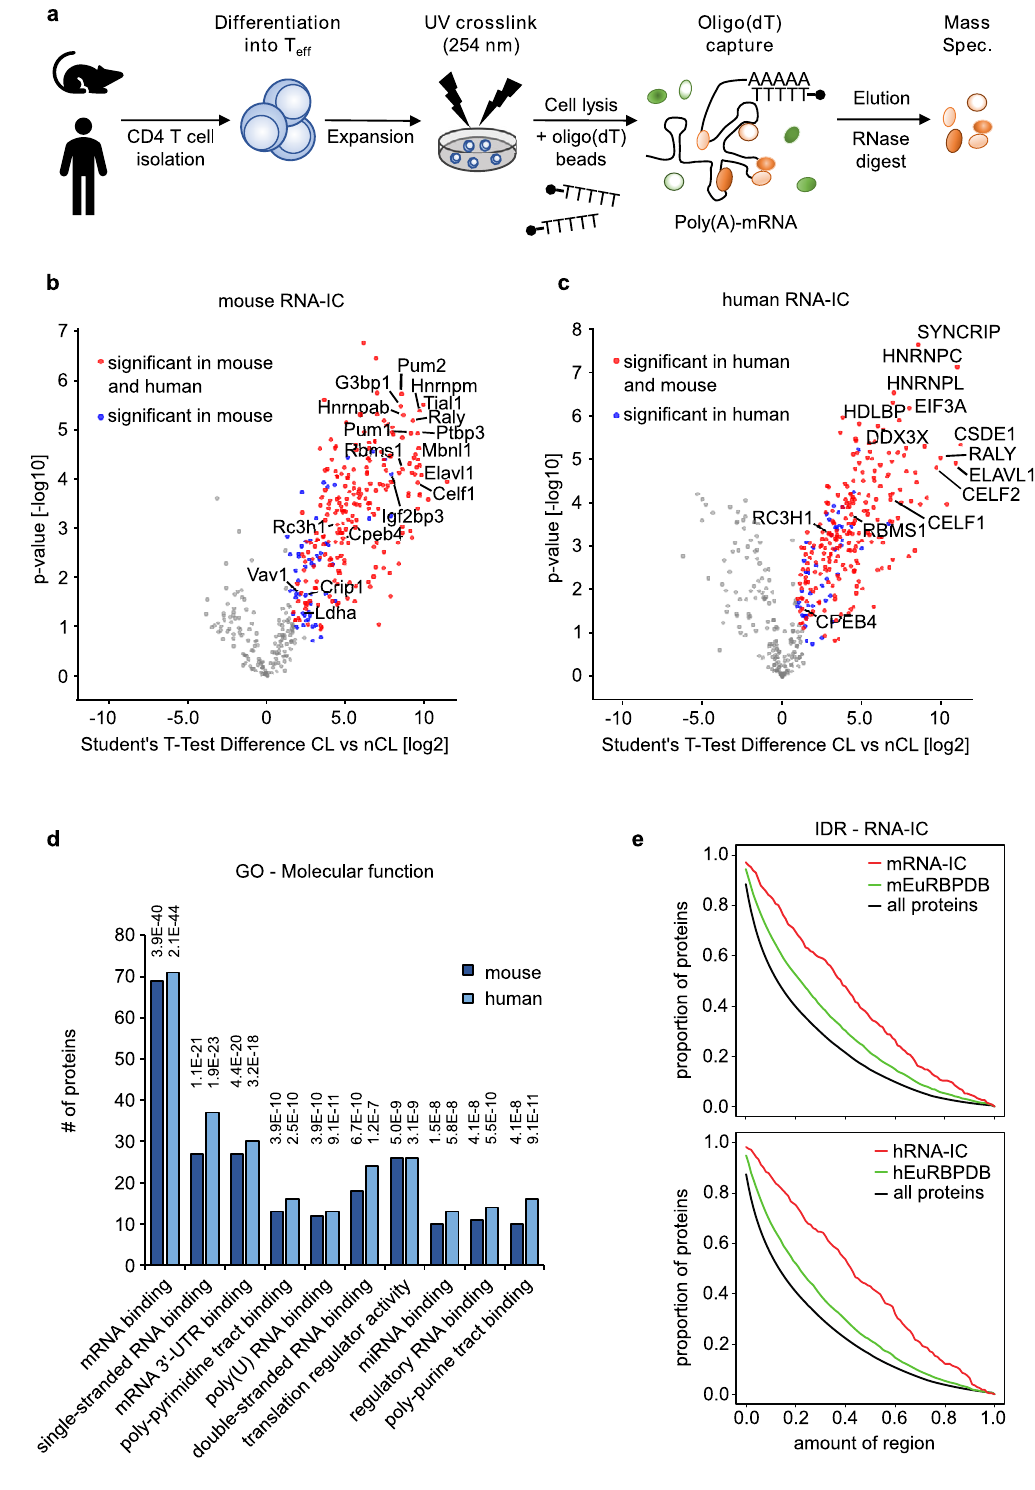
omit cytokines and antibodies that skew them into speci fi c subsets (Fig. 2a). Pull-down with oligo-dT beads enabled the enrichment of mRNA-bound proteins, which were increased in response to preceding UV irradiation of the cells, as determined by silver staining (Supplementary Fig. 1c). Reverse transcription- quantitative PCR (RT-qPCR) con fi rmed the recovery of speci fi c mRNAs, such as for the housekeeping genes Hprt and β -actin . Both mRNAs were enriched at least 2 – 3 fold after UV crosslink, but there was no detection of non-polyadenylated 18S